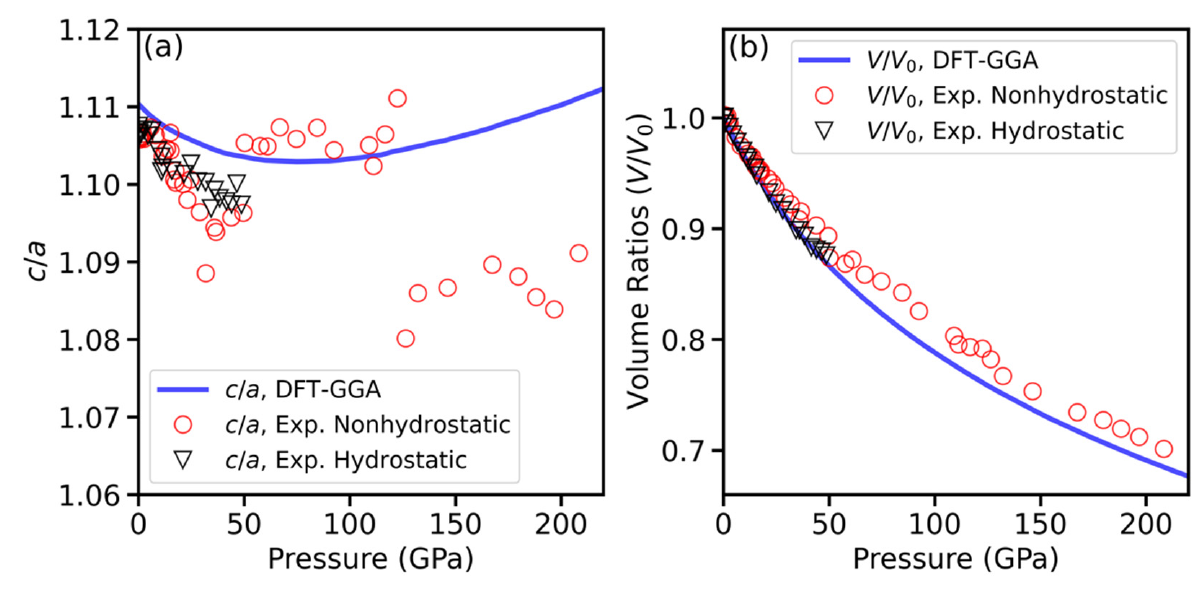
Figure 5. Pressure dependences of ( a ) lattice parameter c/a ratio, and ( b ) unit cell volume V/V 0 ratio for HfB 2 . The density functional theory (DFT) calculations used the generalized gradient approximation (GGA) functional and are plotted together with the experimental data.